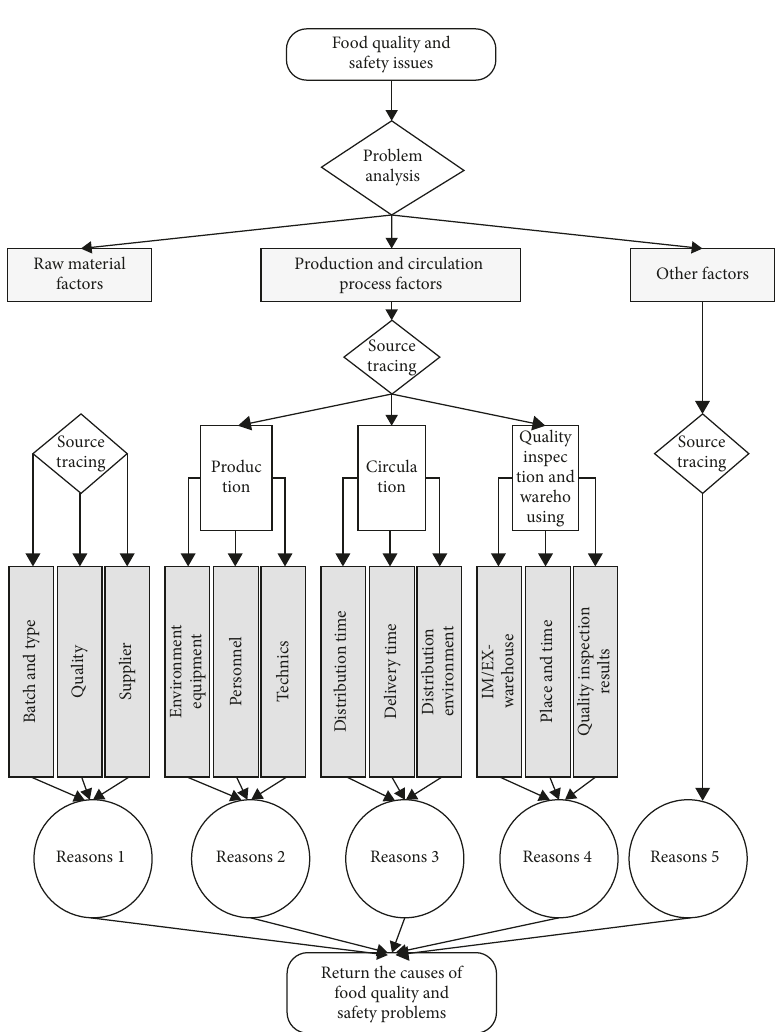
Figure 3: Flow of food quality source